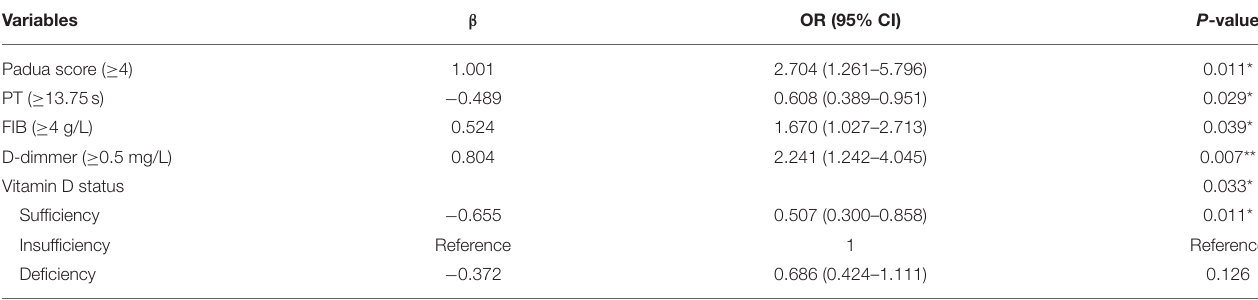
TABLE 5 | Multivariate logistic model of DVT among stroke